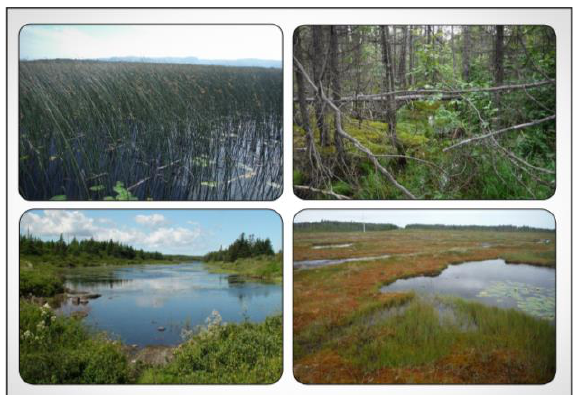
Figure 2. Various wetlands in Newfoundland and Labrador, Canada. From top left to bottom right: marsh wetland, swamp wetland, shallow-water wetland, bog wetland.